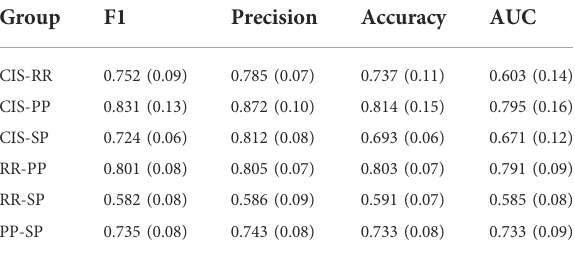
TABLE 6 Ablation study: Mean (st.dev) of the predictive performances oftheSVMmodelacrossthetenfoldsofthecrossvalidationusing Glasser 2016